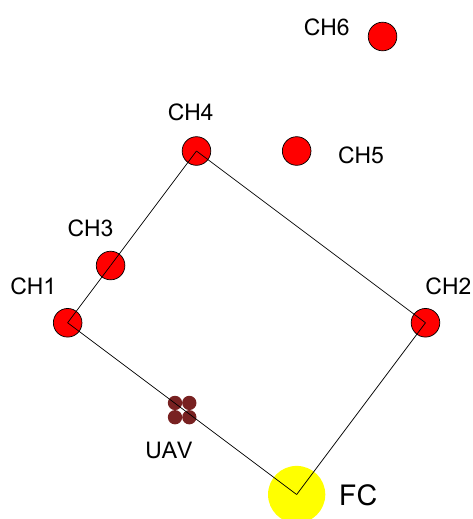
Figure A1. The whole multi-robot system consists of a fusion center (FC) where the UAV starts its route and 6 cluster of robots around FC. The red circles show the locations of the cluster head (CH) robots in their robot cluster. The UAV uses the strategy π 1 for the data collection . With respect to this initial position of the UAV at ξ 0 = ( 0,0 ) , the positions of the CH robots are ( ξ 1 , ξ 2 , ξ 3 , ξ 4 , ξ 5 , ξ 6 ) =